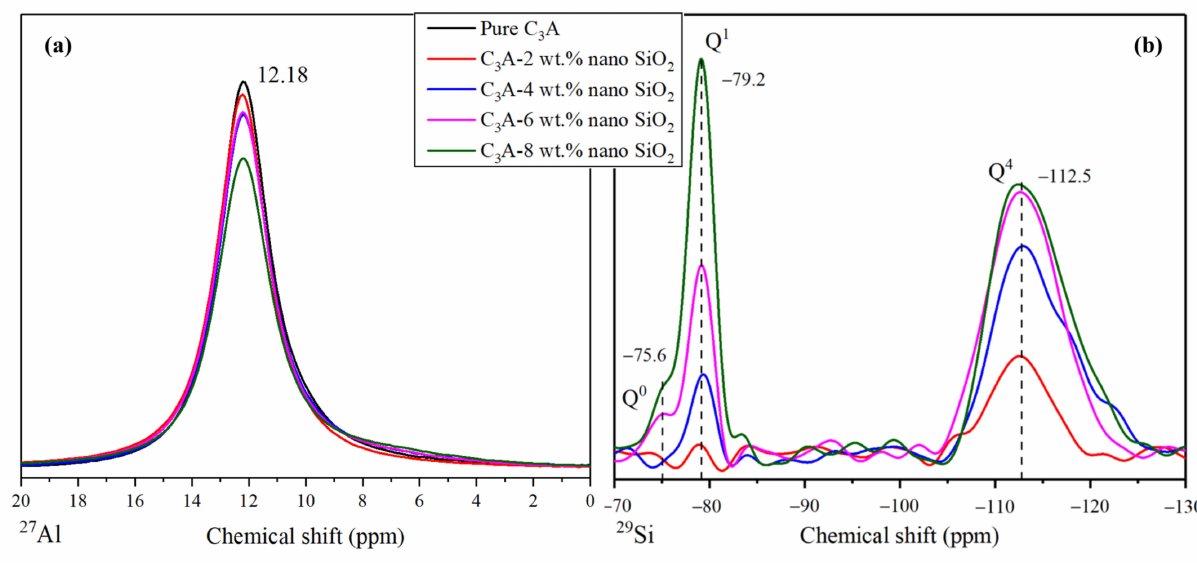
Figure 5. MAS-NMR signal obtained for ( a ) 27 Al and ( b ) 29 Si. 29 Si measurement shows a large number of peaks; meanwhile, 27 Al shows one peak uniquely.